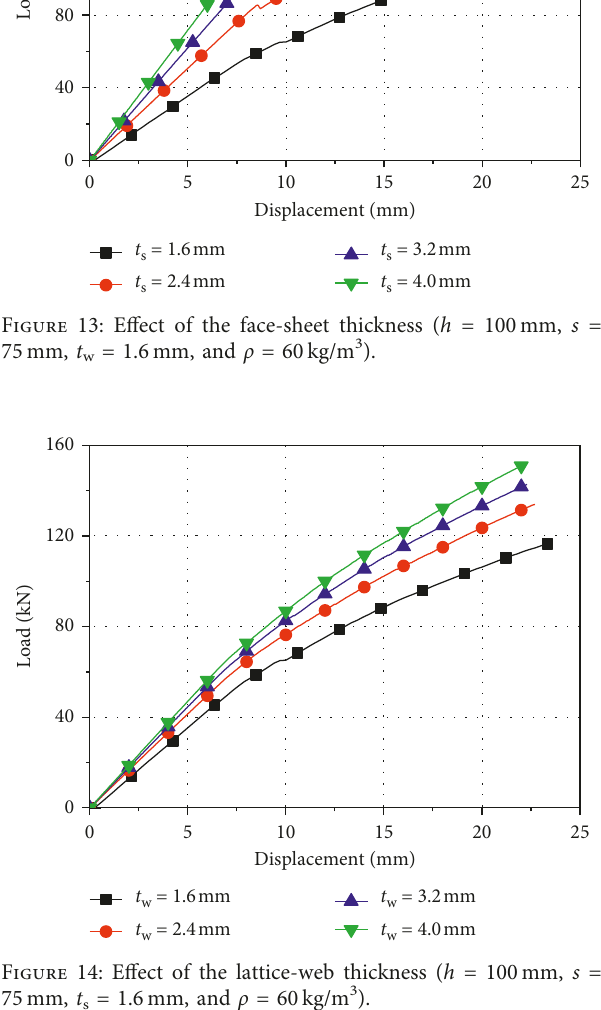
100mm, s (cid:30) (cid:30)